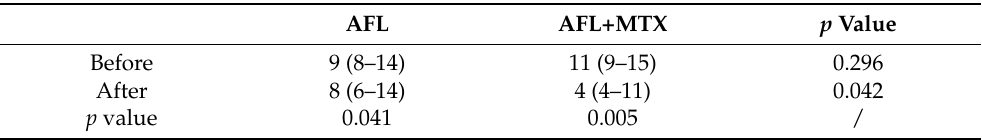
Table 2. The LoSCAT scores four weeks before and after treatment. Data are expressed as median and inter-quartile range. Values of p < 0.05 are considered statistically significant. AFL group was treated by ablative fractional laser and AFL+MTX group was treated by ablative fractional laser-assisted delivery of methotrexate.